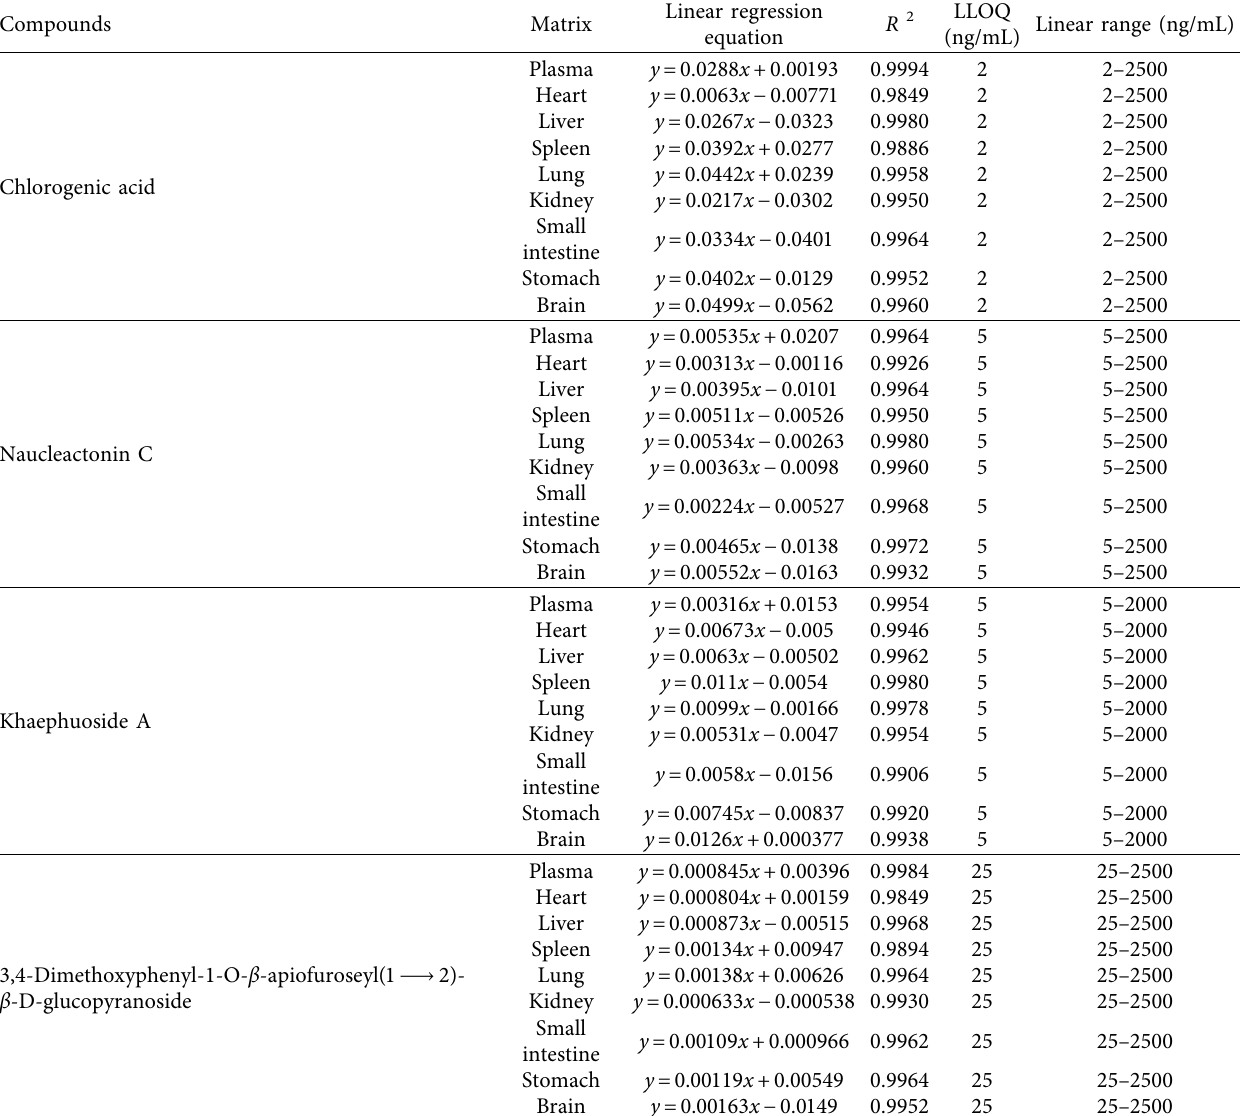
Table 2: Summary of standard curves, correlation coefcients, LLOQ, and linear ranges of four analytes in plasma and tissue samples. Compounds Matrix